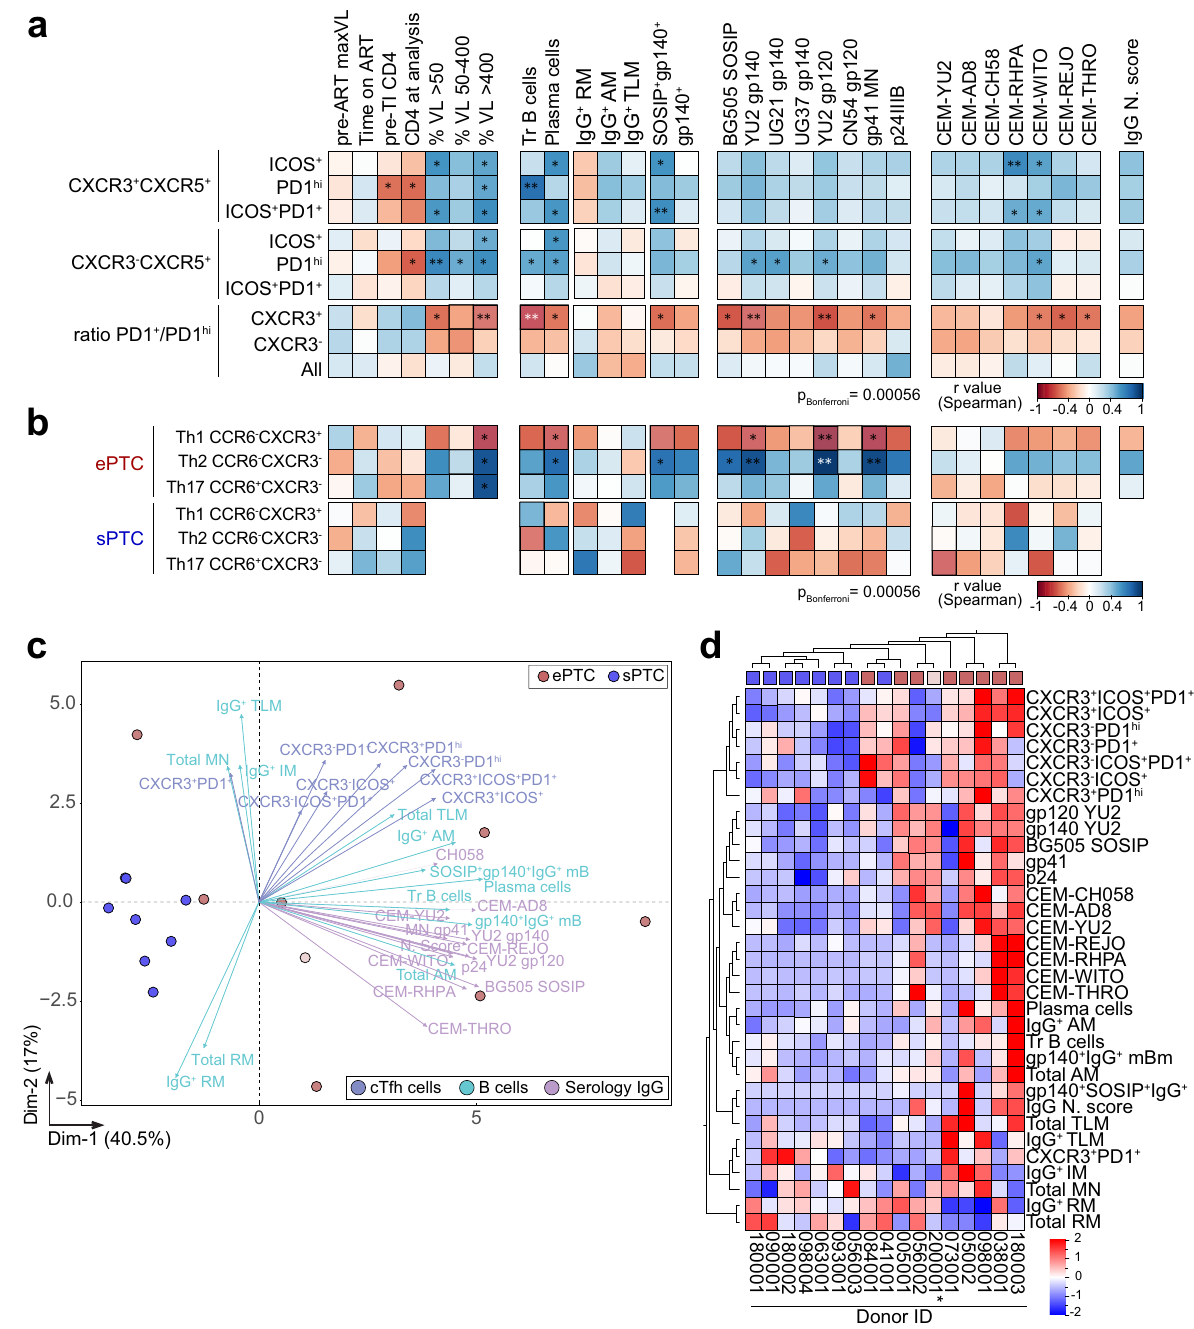
Fig. 7 Humoral immune parameters differentiating ePTC and sPTC. a Correlation matrixes showing the correlation analyses between activated cTfh-cell subsets (%) and selected clinico-virological and humoral parameters measured in PTC. b Same as in ( a ) but for the Th1, Th2 and Th17-like cTfh-cell subsets in ePTC and sPTC. Cells are color-coded according to the value of two-sided Spearman rho correlation coef fi cients. Asterisks correspond to unadjusted p values. *** p < 0.0001, ** p < 0.01, * p < 0.05. p values below the Bonferroni-corrected signi fi cance threshold are highlighted in white. Detailed correlation results are presented in Supplementary Data 1. c PCA 2D-plot shows B-cell, cTfh-cell, and serological antibody related variables discriminating ePTC (red, n = 9) from sPTC (blue, n = 8). The two fi rst dimensions account for 57.5% of the variability. The location of the variables is associated with the distribution of the donors. ePTC rebounder 200001 is shown in light red. d Heatmap shows the unsupervised hierarchical cluster analysis of the variables shown in ( c ) using standardized z score values. Top red and blue squares correspond to ePTC and sPTC, respectively. ePTC rebounder 200001 is indicated by an